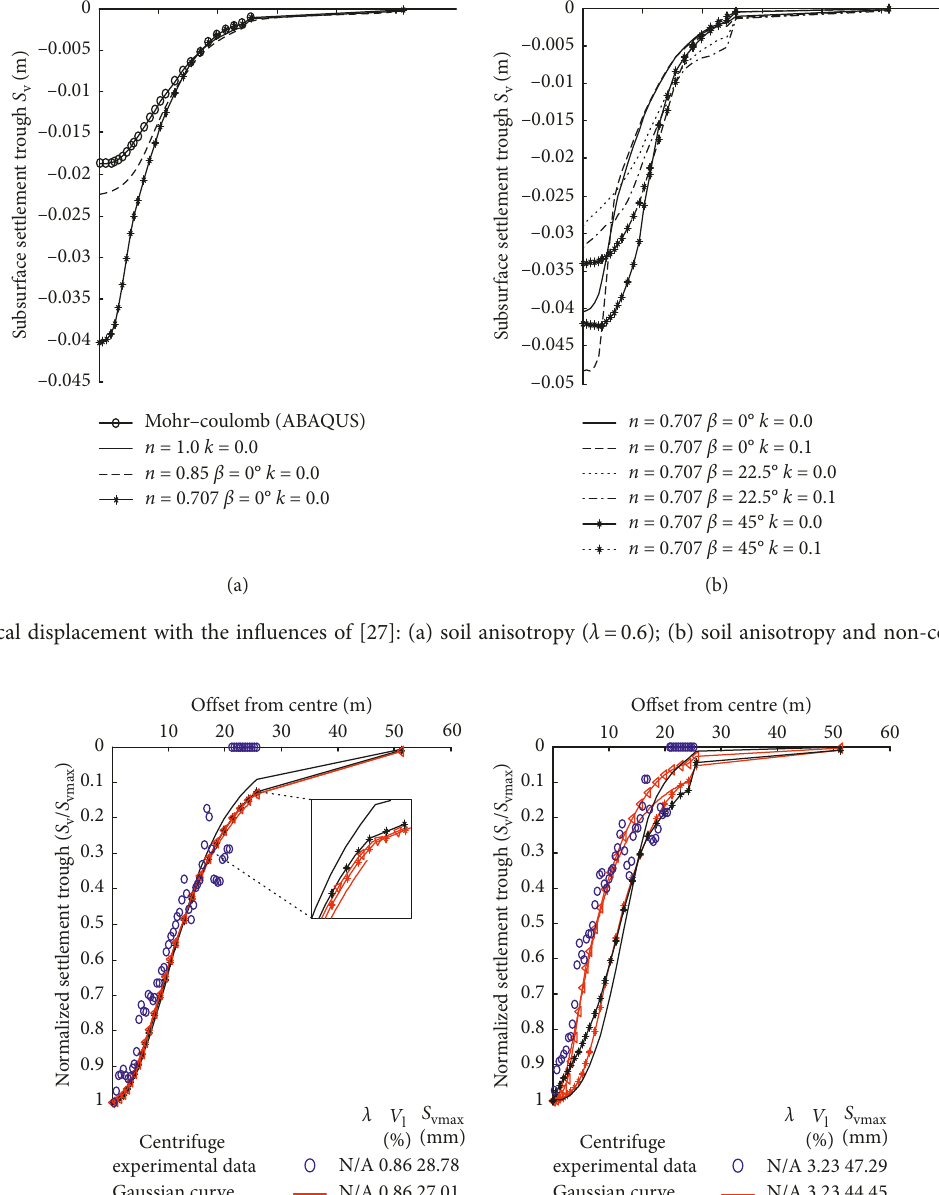
. 86% [27]; (b) V . l (cid:31) 0 l (cid:31) 3